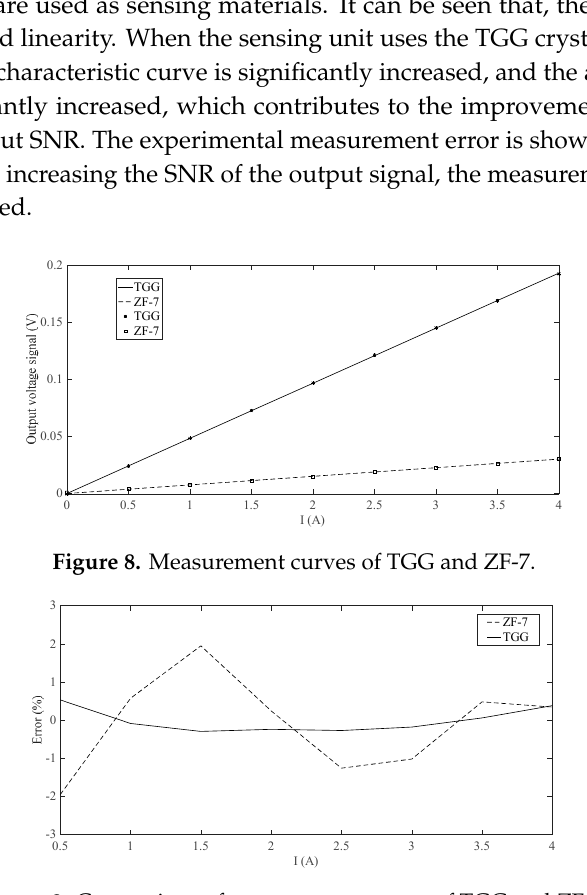
Figure 9. Comparison of measurement errors of TGG and ZF-7.